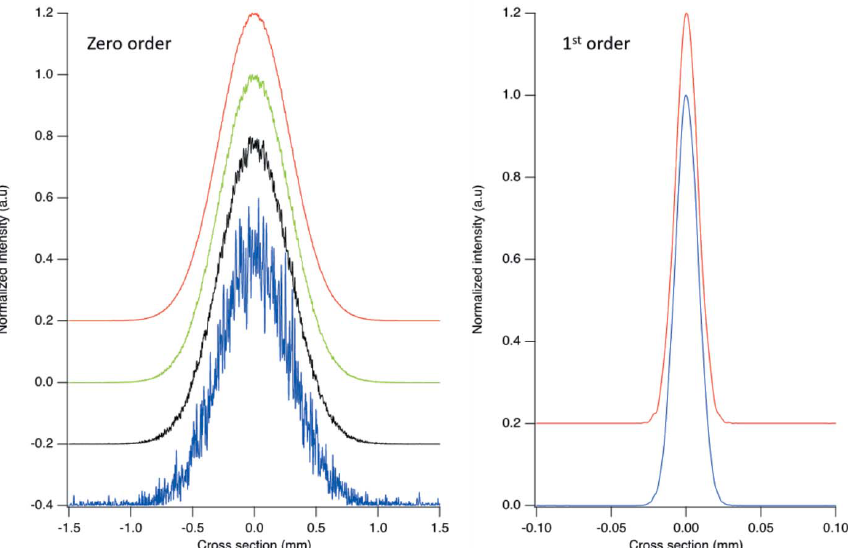
Figure 6 Cross section of the unfocused zero order (left) and focused first order (right) at 920 eV. The groove depths are 1 nm (red curves), 2.5 nm (green), 5 nm (black) and 10 nm (blue). Because there is no appreciable effect on the focused first-order beam, only the profiles for the extreme cases are